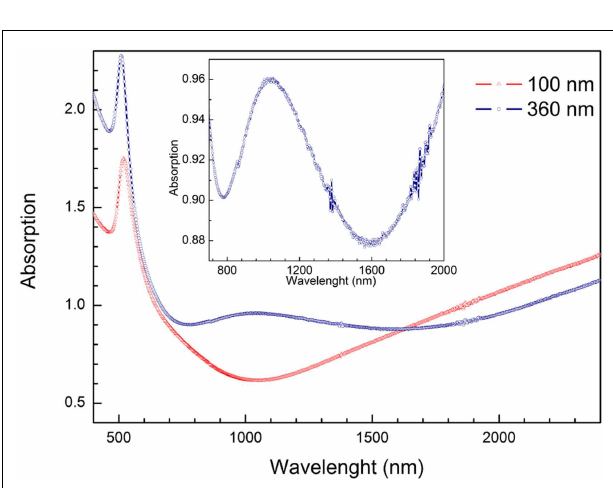
FIGURE 7 |Absorption spectra of exposedAu-NRs of different length on a glass substrate terminated with a 5nmAu-film . Incidence of non-polarized light is normal to the plane of the NR array.The mode at approximately 520nm is the LSPR transverse mode. For the 360nm long NRs, the longitudinal mode at approximately 1020nm is distinctly observed, whereas only a shoulder at approximately 700nm is observed for the short